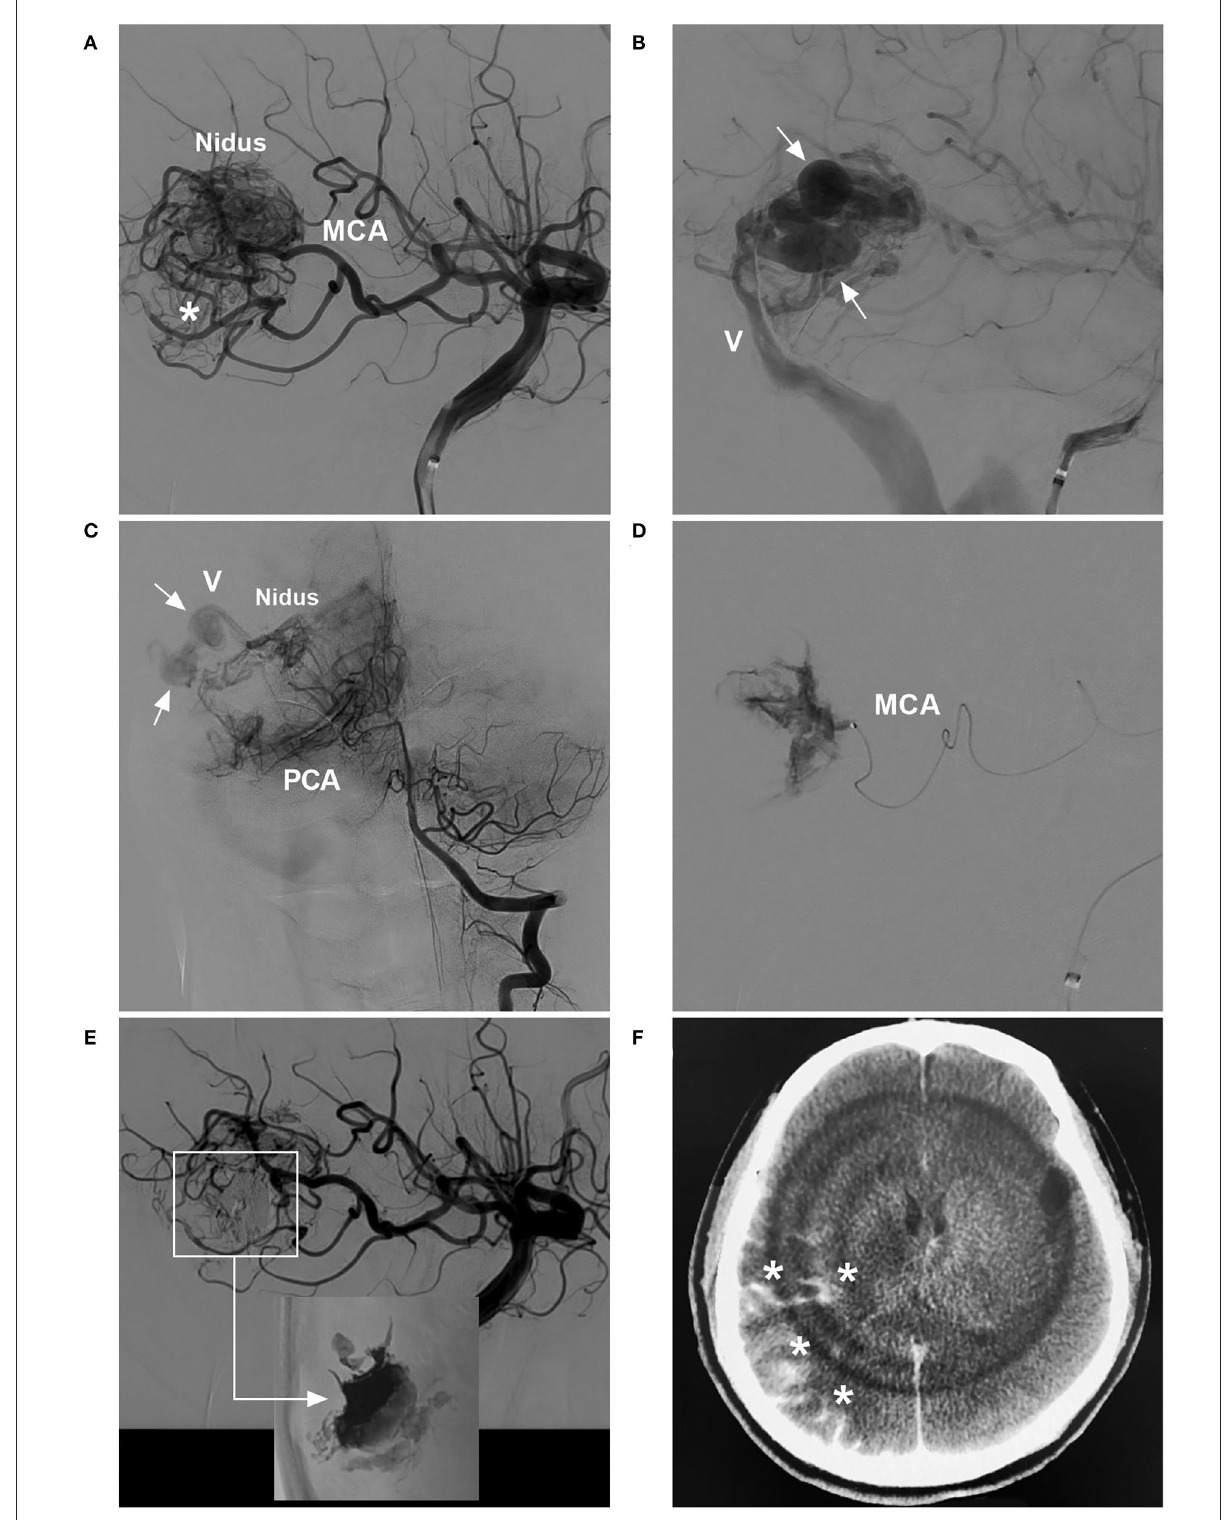
FIGURE3 BAVM with intraoperative nidus perforation (case 12). (A) Arterial-phase angiogram of the ICA showing the BAVM supplied by the MCA. (B) Late arterial-phase angiogram of the ICA showing the draining vein (V) with venous aneurysms (arrows). (C) Arterial-phase angiogram of the